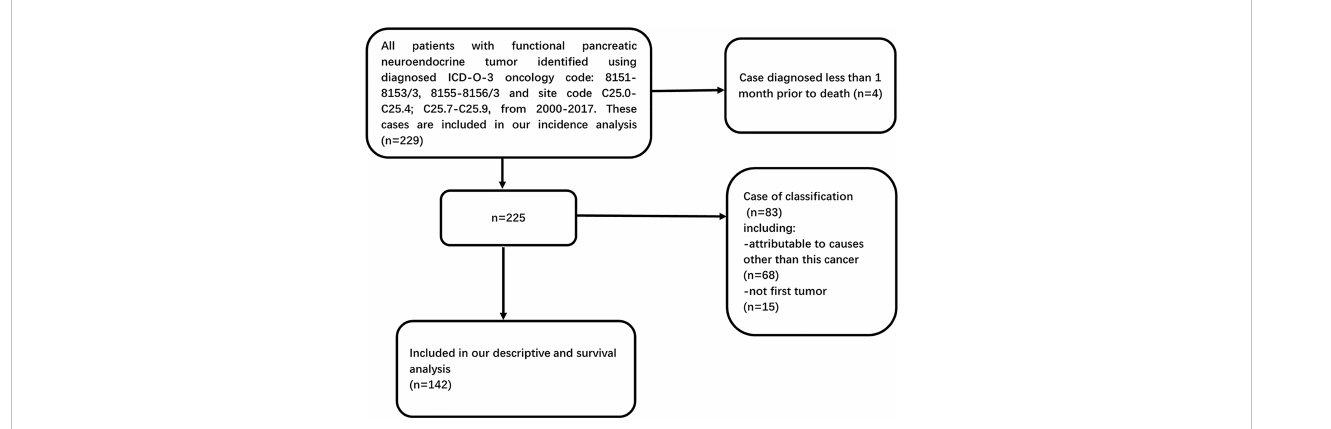
FIGURE 1 Flow diagram of inclusion and exclusion criteria in our descriptive (excluding incidence trends) and survival analysis within SEER database 2000 –